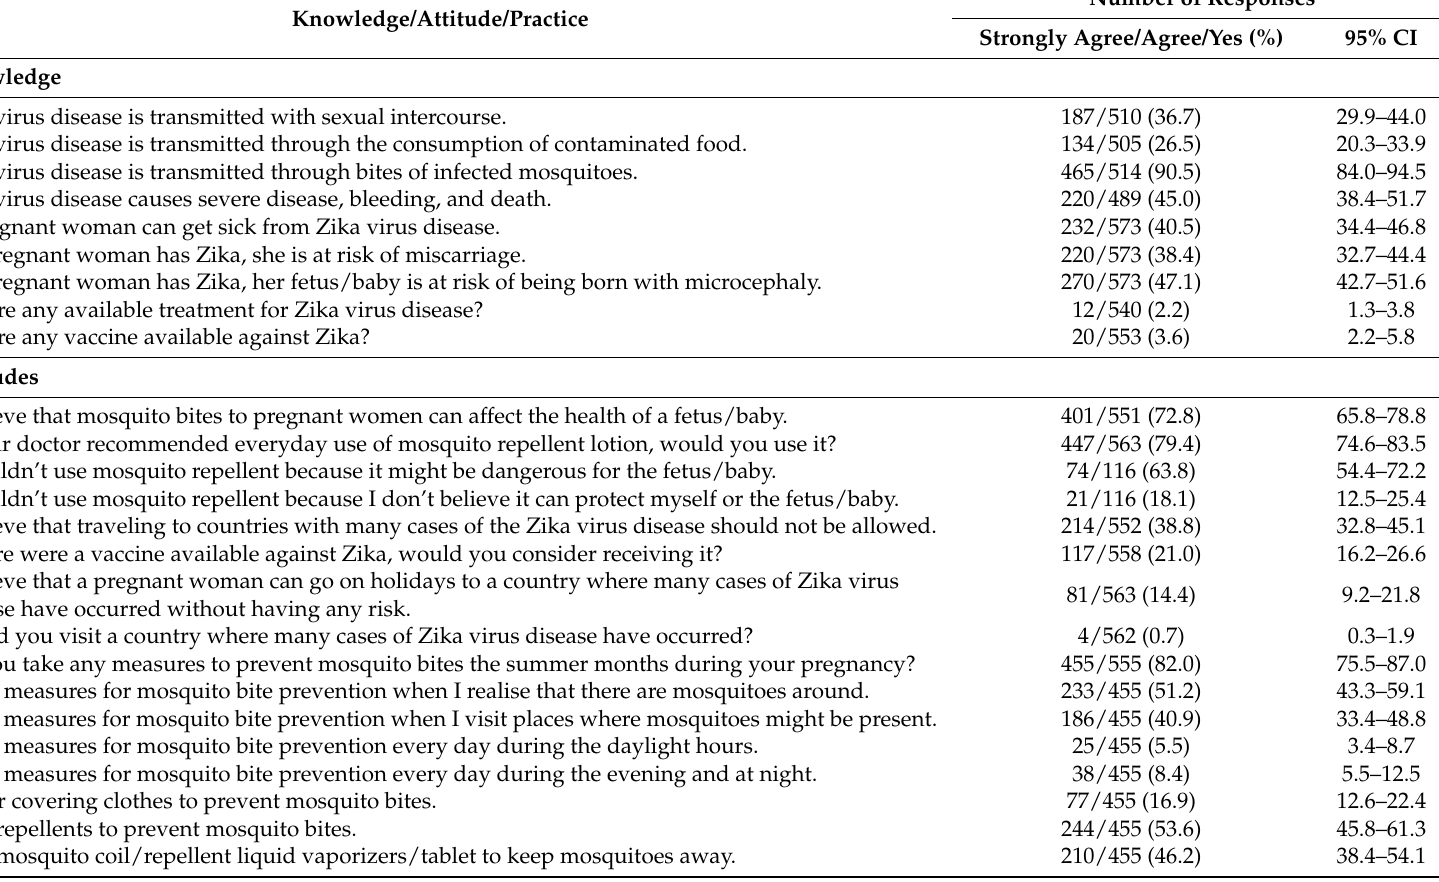
Table 2. Knowledge, attitudes, and practices (KAPs) for Zika virus disease and sexual contact protection among pregnant women in